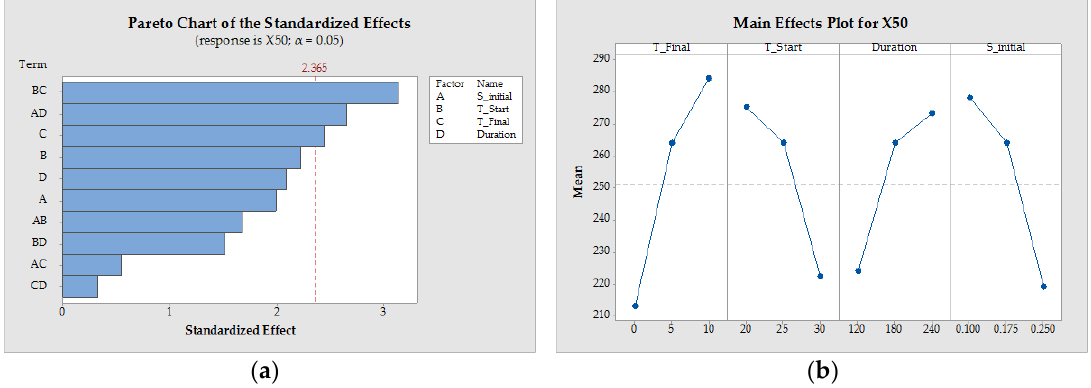
Figure 8. Influences on Yield TDL : ( a ) significances and ( b ) main effects (TDL: Thermodynamic limit).